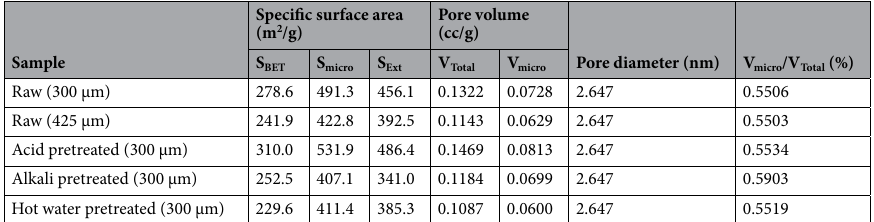
Table 9. Pore characteristics of sugar cane bagasse biomass (raw and pretreated).